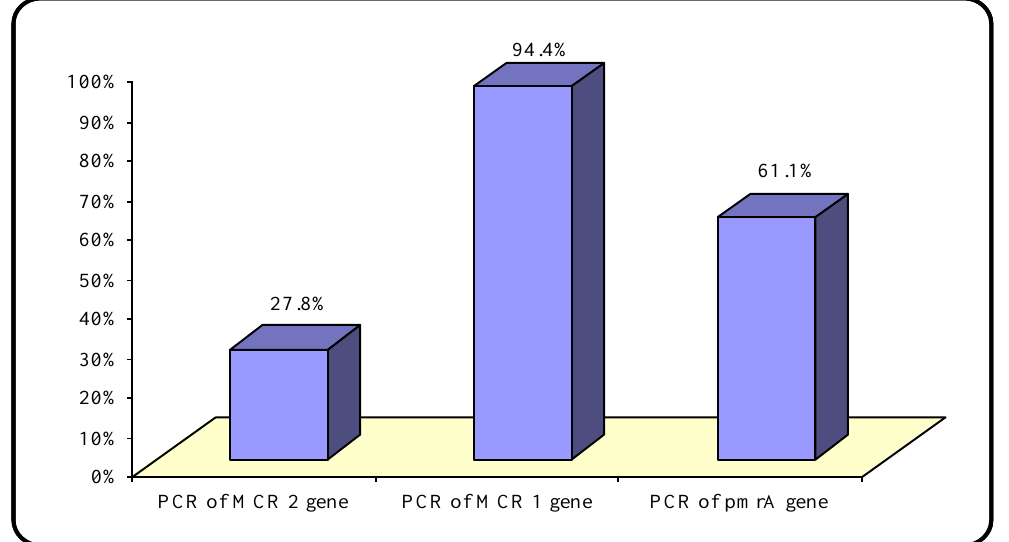
Figure 2. Frequency of colistin resistance genes among colistin resistant